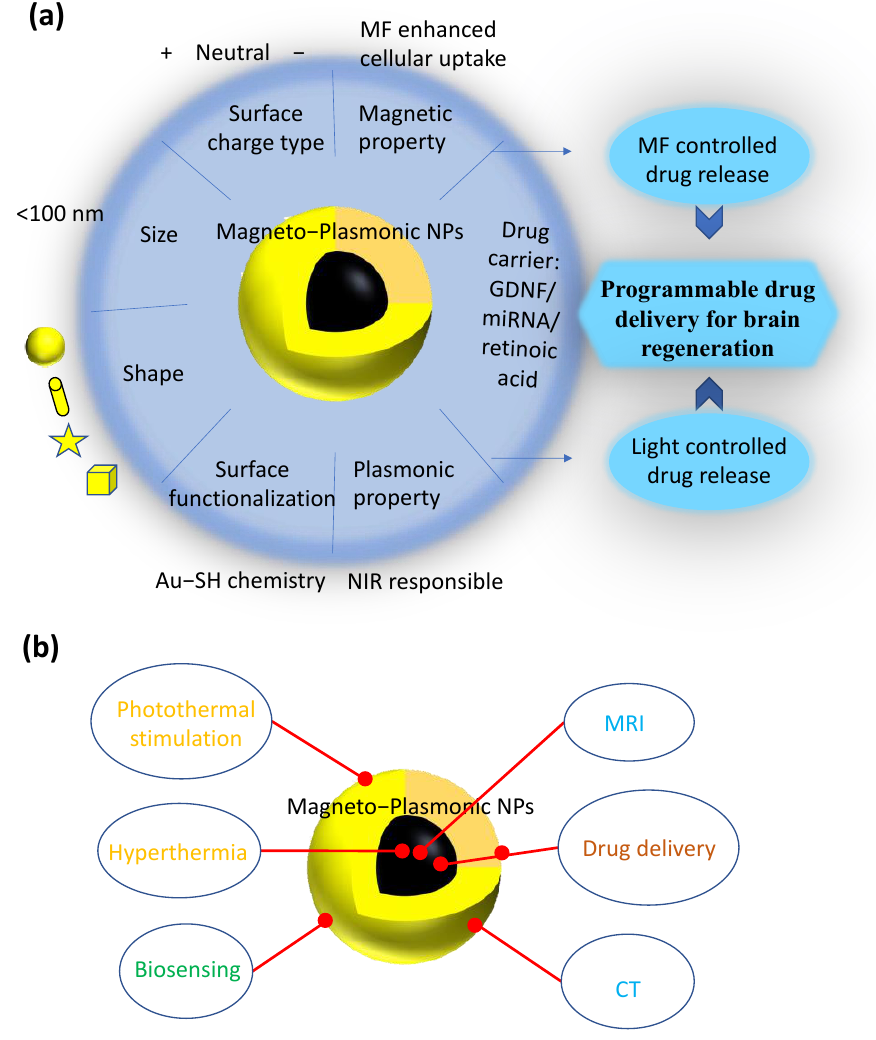
Figure 1. Schematic of ( a ) magneto-plasmonic nanoparticle (NP) properties and their application for programmable drug delivery; ( b ) applications of magneto-plasmonic NPs for brain-tissue and cellular regeneration.